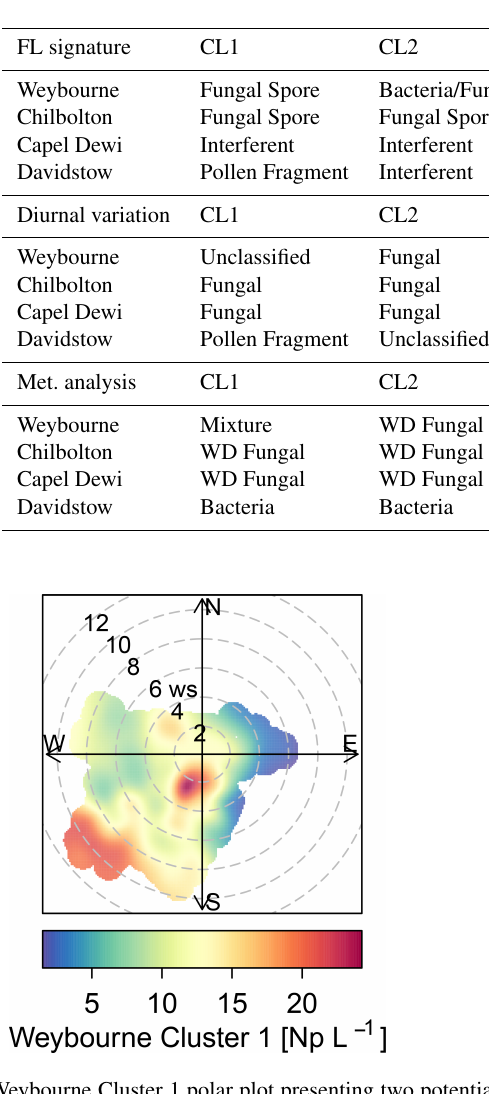
Figure 6. Weybourne Cluster 1 polar plot presenting two potential sources of biological particles, which when using Fig. 1 are likely to comprise improved grassland and arable and horticultural